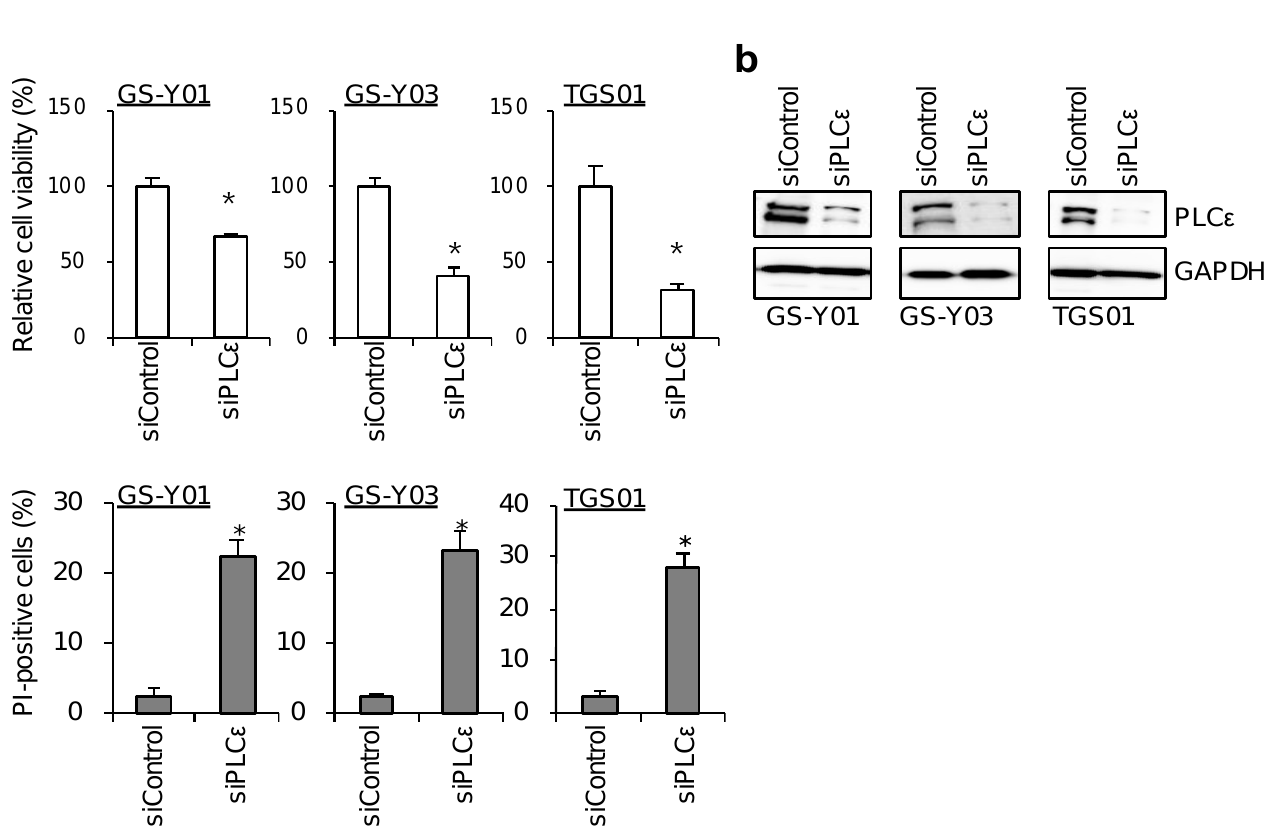
Figure 2. Genetic silencing of PLC ε suppresses cell viability. GSCs (GS-Y01, GS-Y03, and TGS01) were transiently transfected with siRNA against PLCE1. The cells were then subjected to a cell viability assay using WST-8 ( a ), Western blot analyses ( b ), or a propidium iodide (PI) uptake assay ( c ). The values represent the means + SDs of the triplicate samples of a representative experiment. Similar results were obtained from two independent biological replicates. * p < 0.05 vs. siControl-transfected cells by the Student’s t -test. Representative fluorescence images of are shown at Supplemental Figure S2.